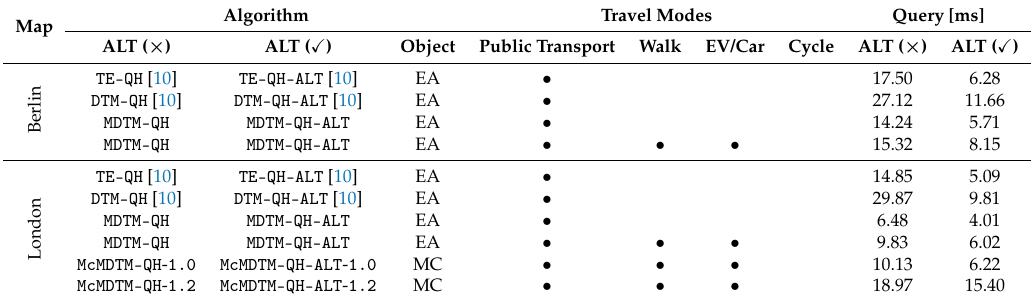
Table 6. Comparison between query algorithms. Symbol × ( (cid:88) ) denotes a query algorithm without (or with) ALT. McMDTM-QH - [ALT-]1.0 ( McMDTM-QH - [ALT-]1.2 ) denotes McMDTM-QH - [ALT] with r mc = 1 ( r mc = 1.2). Bullets ( • ) indicate the options taken into account. EA denotes an earliest arrival journey. MC denotes a multicriteria journey on arrival time and number of